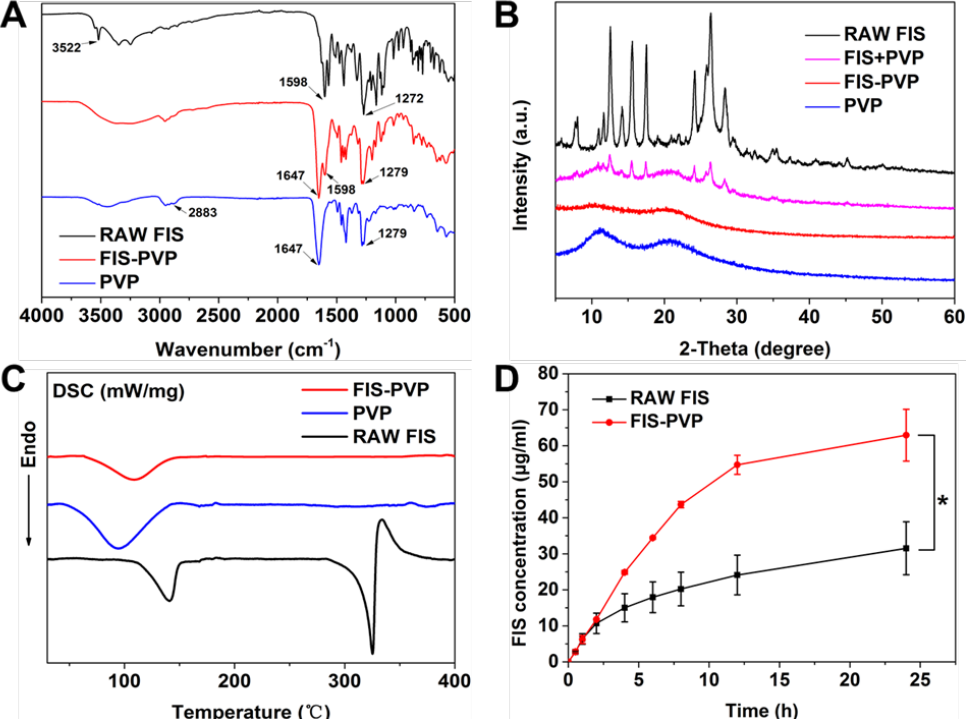
Figure 6. ( A ) FTIR spectra of raw FIS, pure PVP, and FIS-PVP NPs. ( B ) XRD patterns of raw FIS, pure PVP, the physical mixture of FIS+PVP, and the SAS-processed FIS-PVP NPs. ( C ) DSC thermograms of raw FIS, pure PVP, and the SAS process-based FIS-PVP NPs. ( D ) Amount of soluble FIS in raw FIS as well as that released from the SAS process-assisted FIS-PVP NPs.